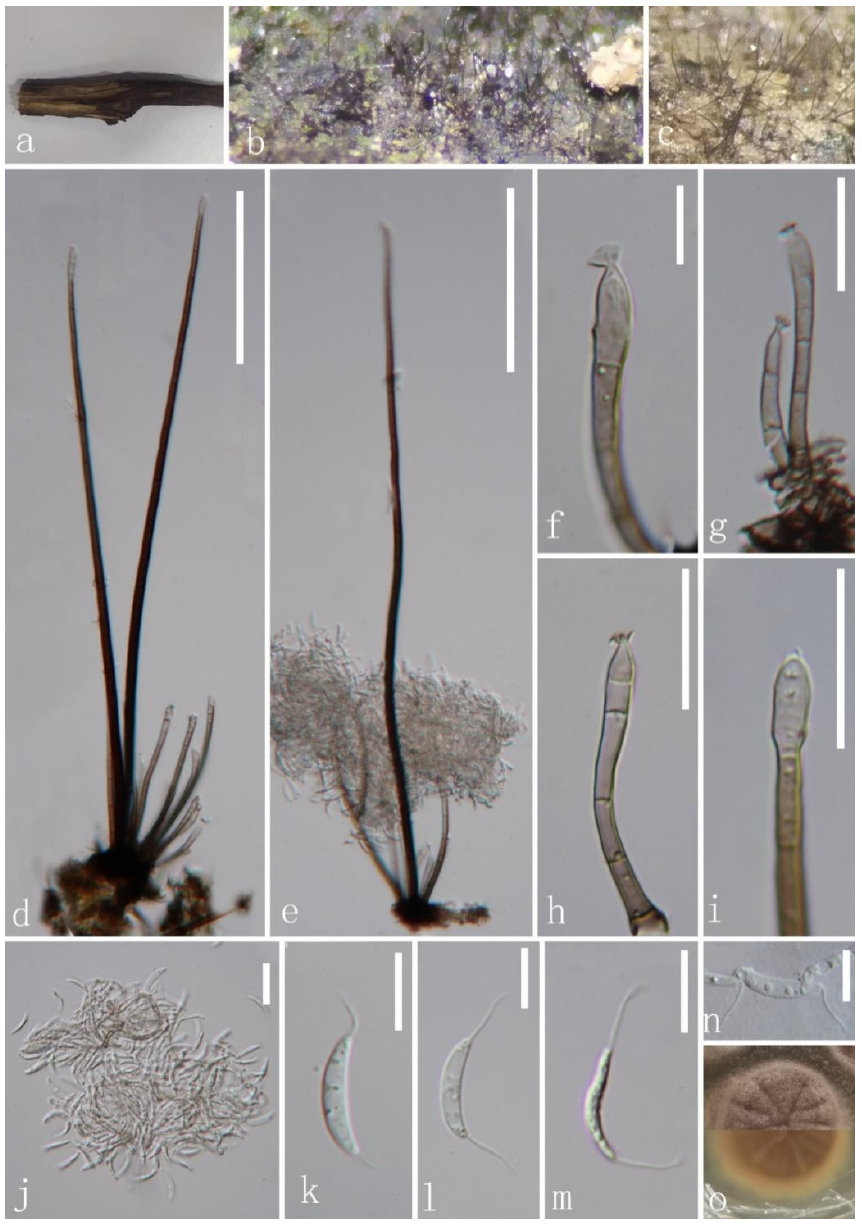
Figure 3. Codinaea aseptata (HKAS 123758, holotype). ( a ) Host material; ( b , c ) colonies on woody substrate; ( d , e ) setae and conidiophores; ( f – h ) conidiophores and conidiogenous cells; ( i ) apex of seta ； ( j – m ) conidia; ( n ) germinated conidium; ( o ) culture on PDA from above and below. Scale bars: ( d , e ) 100 μ m; ( f , k – n ) 10 μ m; ( g – j ) 20 μ m. Codinaea dwaya (Subram. and J. Bhat) Réblová and Hern.-Restr., Journal of Fungi 7 (12, no. 1097): 31 (2021) (Figure 4).